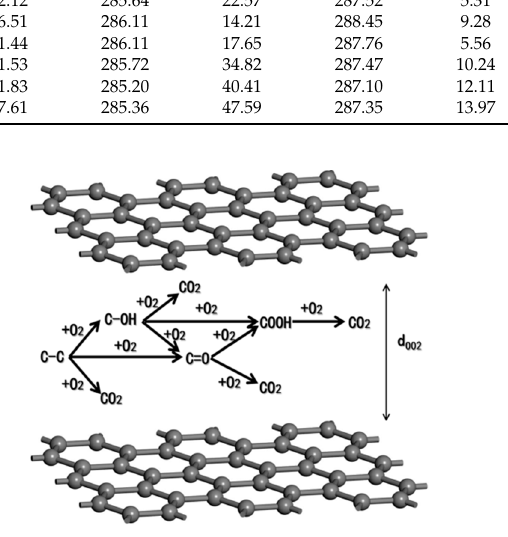
Figure 9. Transformation schematic diagram of oxygen-containing functional groups between the graphite layers .